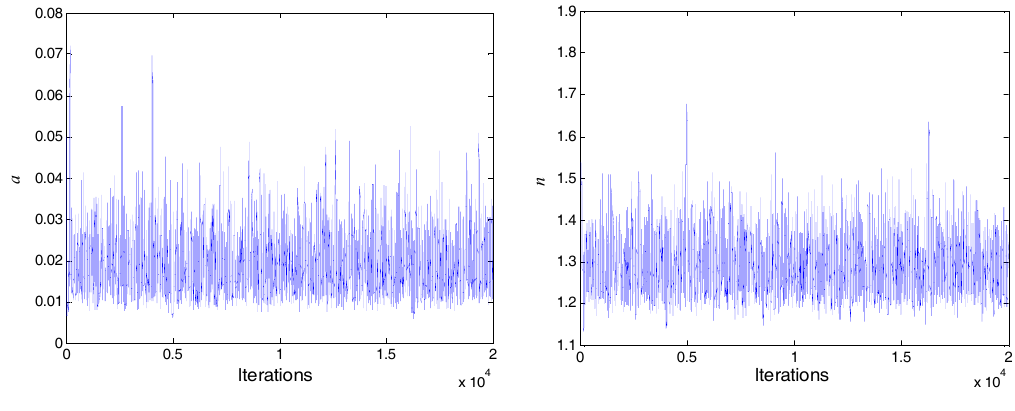
Figure 4. Evolution processes of the random samples.